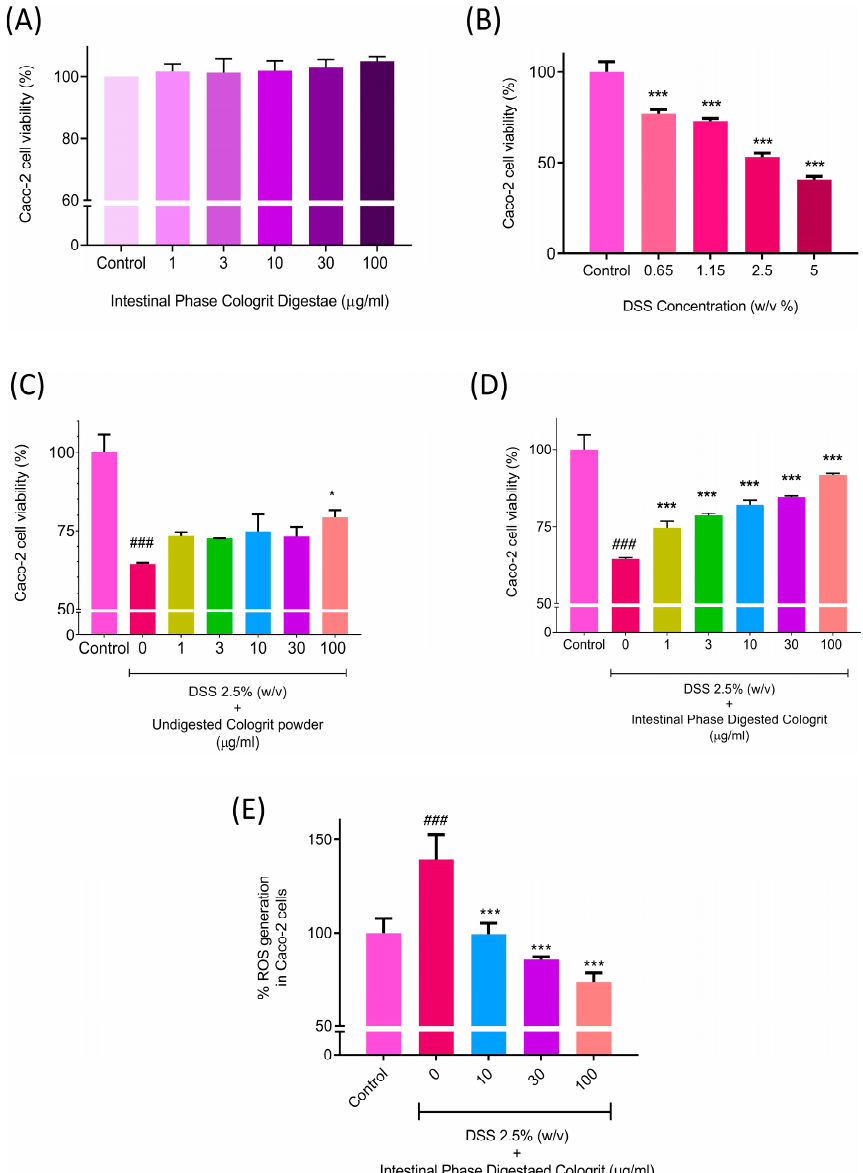
Figure 6. Biological activity of the intestinal phase solubilized EC Cologrit tablets. ( A ) Biocompati- bility analysis of intestinal phase EC Cologrit tablet digestae done on Caco-2 cells, ( B ) dose range screening of dextran disodium sulfate (DSS) in Cac-2 cells performed using cell viability analysis, ( C ) protection against loss of cell viability by undigested EC Cologrit tablet in Caco-2 cells treated with 2.5% ( w / v ) DSS treatment, ( D ) protection against loss of cell viability by EC Cologrit tablet digestae in Caco-2 cells treated with 2.5% ( w / v ) DSS treatment, ( E ) protection against oxidative stress via ROS generation by EC Cologrit tablet digestae in Caco-2 cells treated with 2.5% ( w / v ) DSS treatment. Statistical analysis was performed using one-way ANOVA followed by Dunnett’s posthoc test. ( B ) *** p -value < 0.001 (Control versus (vs.) DSS treatment). ( C – E ) ### p -value < 0.001 (Control vs. DSS (2.5% w/v) treatment; * p -value < 0.05 (DSS (2.5% w/v) treatment vs. Cologrit + DSS (2.5% w/v) treatment; *** p -value < 0.001 (DSS (2.5% w/v) treatment vs. Cologrit + DSS (2.5% w/v) treat- ment).